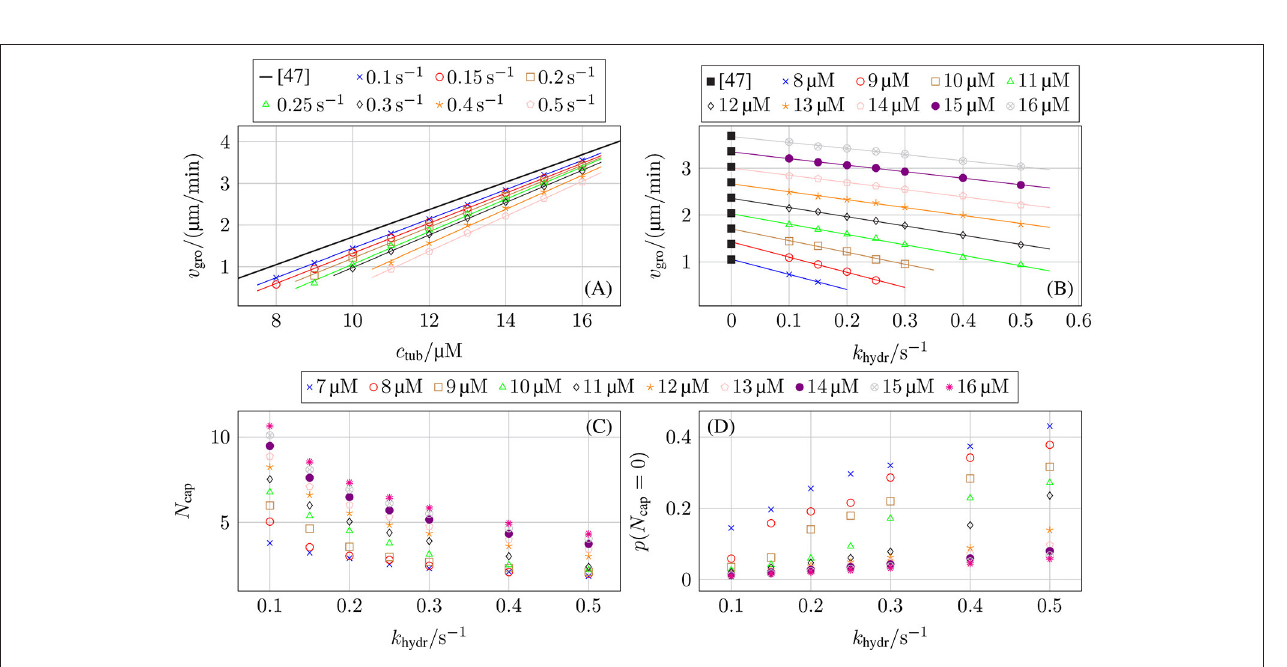
FIGURE 9 | Growth velocity v gro as a function of (A) the free tubulin dimer concentration c tub for different hydrolysis rates k hydr and as a function of (B) the hydrolysis rate k hydr for different free tubulin dimer concentrations c tub in comparison to the experimental data from Walker et al. [47]. (C) Average GTP-tubulin cap length h N cap i of protofilaments and (D) fraction of protofilaments without a GTP-cap as a function of the hydrolysis rate k hydr . The standard set of parameters from Table 2 was